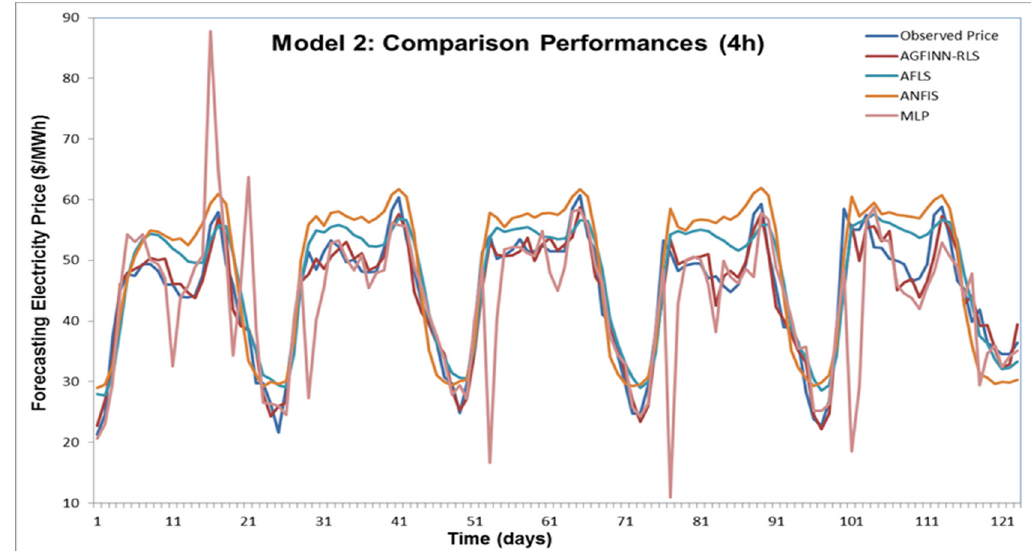
Figure 10. Forecasting for electricity price at 04:00—case study 2.